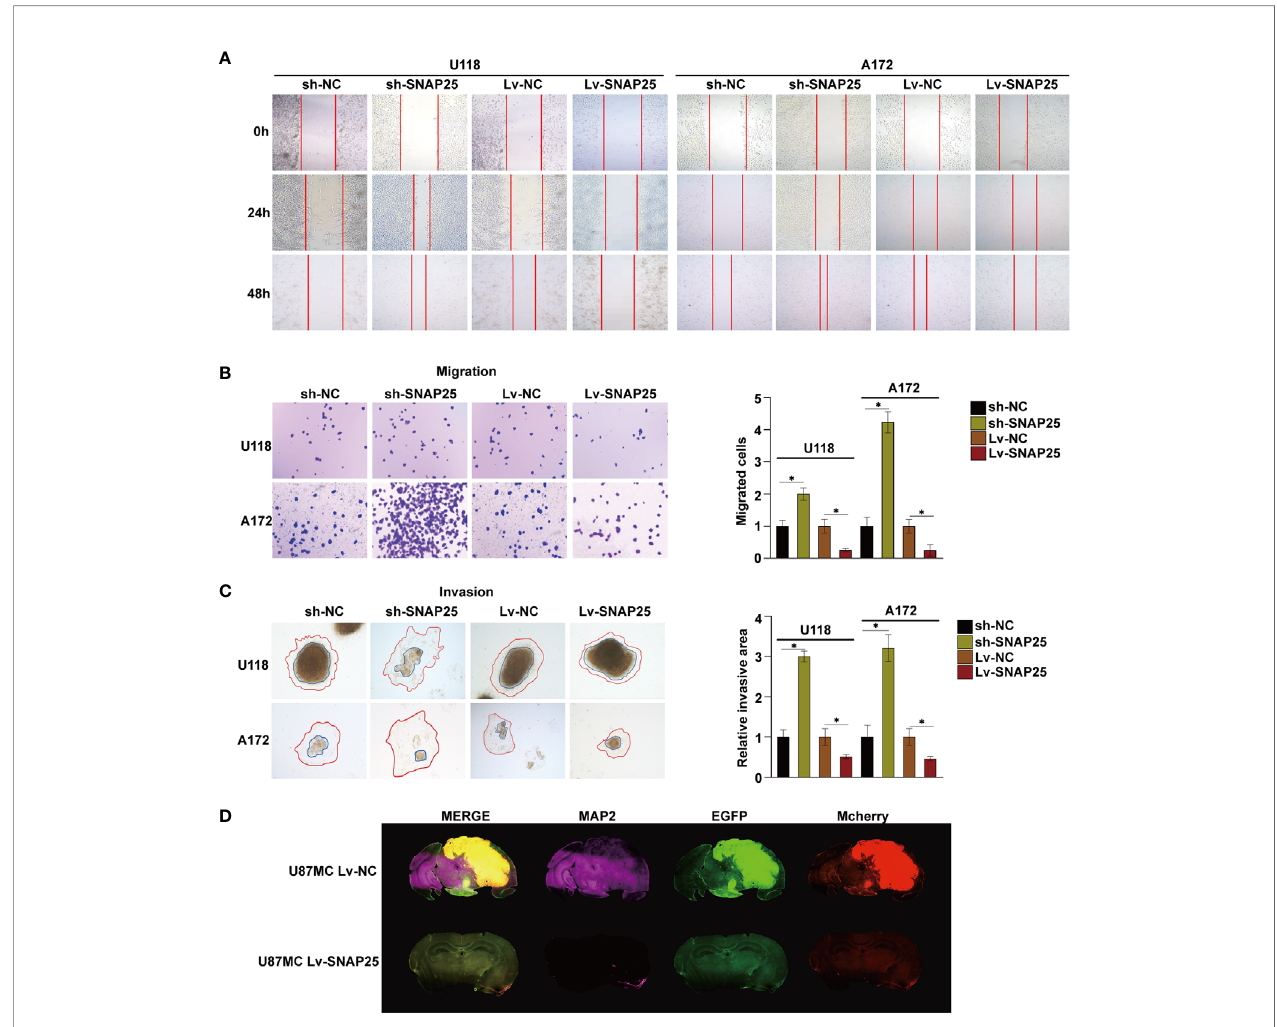
FIGURE 3 | SNAP25 inhibits migration and invasion of tumor cells, and inhibits dendron formation of glioma tissues. (A) Ectopic expression of SNAP25 inhibits cell migration as determined by wound healing assays. (B) Ectopic expression of SNAP25 inhibits cell migration as determined by transwell assays and analysis of representative migrated rates of glioma cells is shown below. * p < 0.05 compared with Lv-NC or sh-NC group. (C) Representative pictures of glioma cell invasion (red curved line: invaded area, blue circle: spheroid) and analysis of quantitative invaded area of glioma cells using Image J software is shown below. * p < 0.05 compared with Lv-NC or sh-NC group. (D) Glioma cell (Mcherry staining) and neuronal dendron (MAP2 staining) in the brains of indicated mice at the time of harvesting (Day